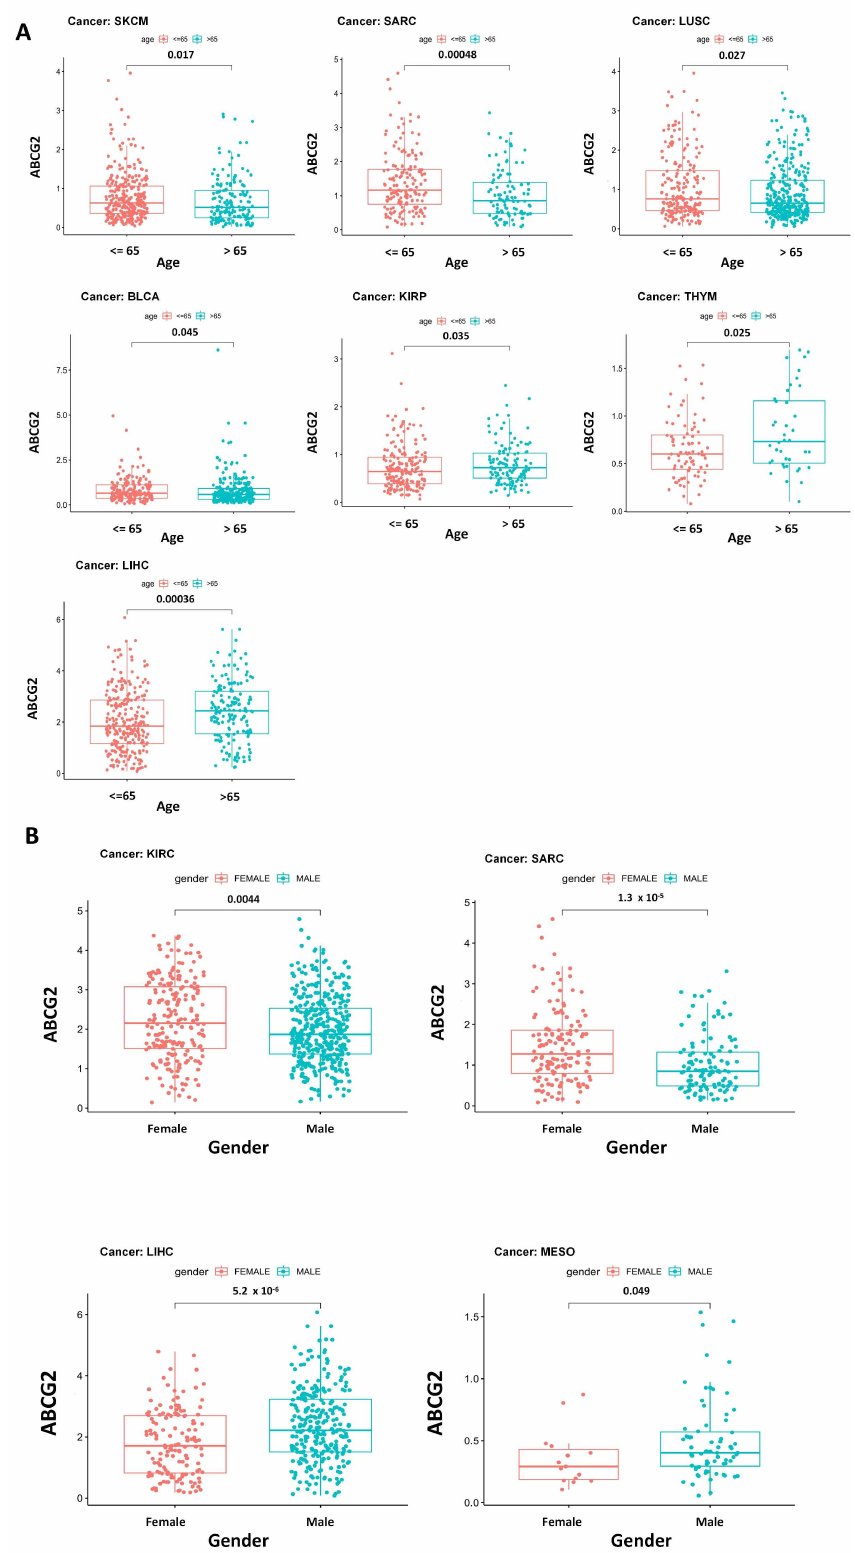
Figure 5. Correlation between ABCG2 gene expression and the clinicopathological characteristics of different cancer types: ( A ) age ( ≤ 65 and >65) and ( B ) gender (female and male) with significant results are